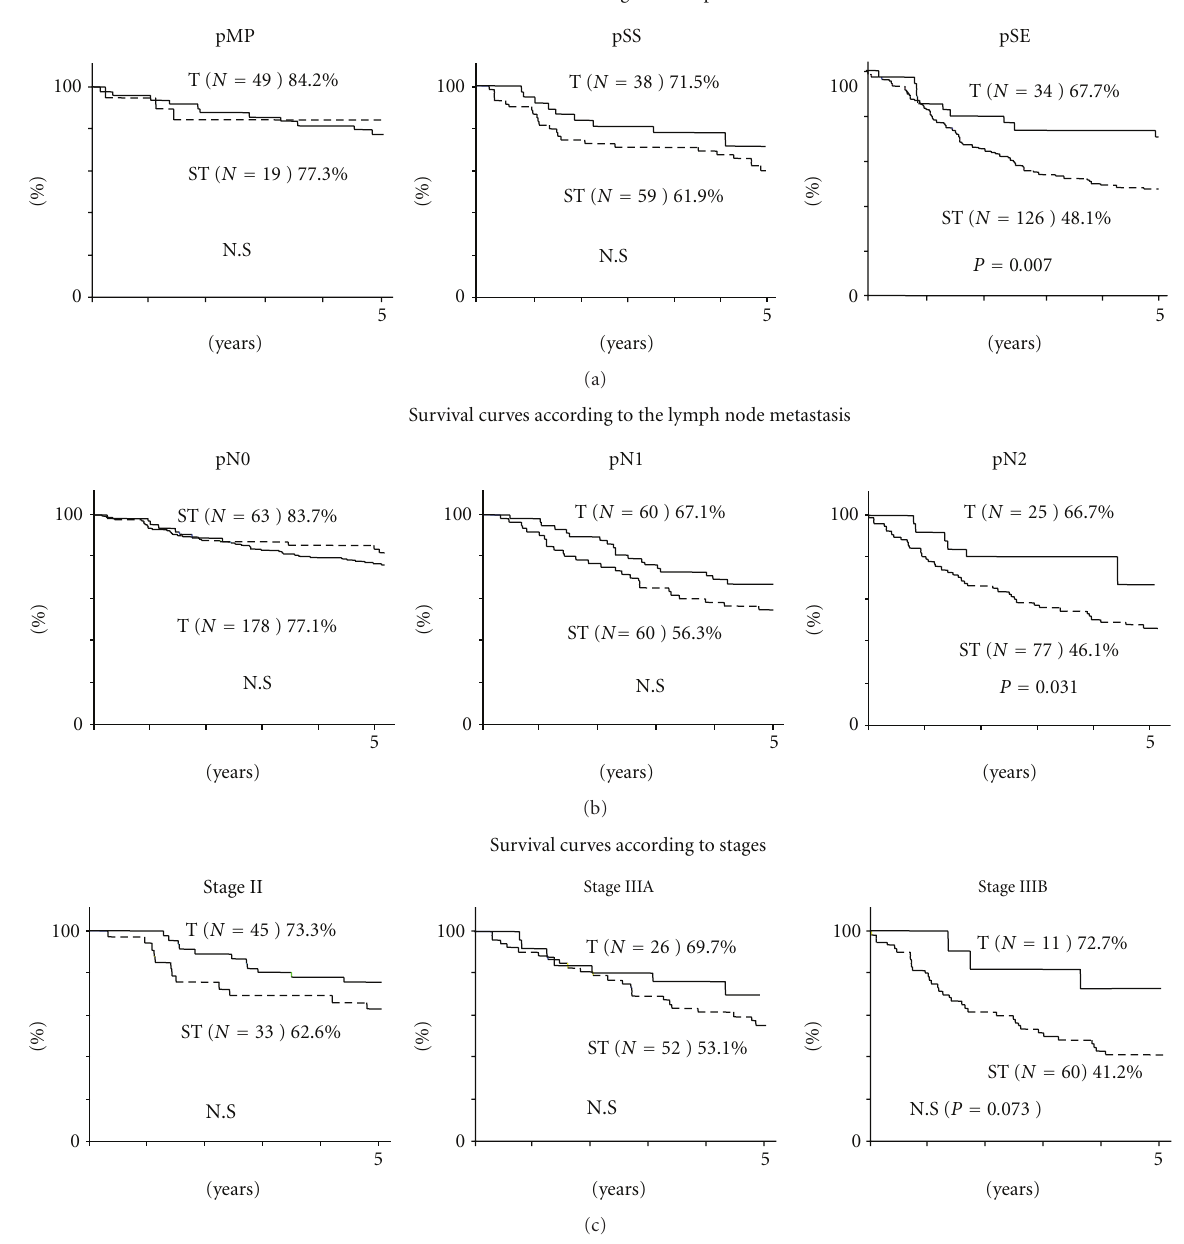
Figure 5: (a) Cumulative survival rates according to the depth of invasion (pT). As for pMP and pSS, there was no di ff erence between T group and ST group, but the survival of the T group with pSE was better than that of ST group with pSE ( P = 0 . 007). (b) Cumulative survival rates according to lymph node metastasis (pN). There was no di ff erence in the cumulative survival rates between two groups with pN0 and pN1, but the survival of T group with pN2 was better than that of ST group with pN2 ( P = 0 . 031). (c) Cumulative survival curves according to stage (pStage). There was no significant di ff erence in the cumulative survival rates between two groups with Stage II, Stage IIIA, and Stage